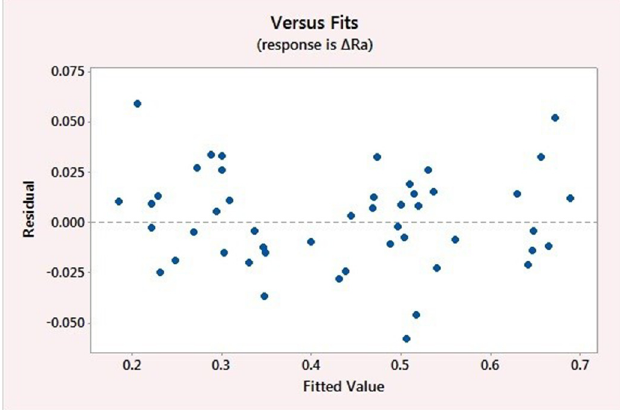
Fig. 4. Residuals vs. Fitted values